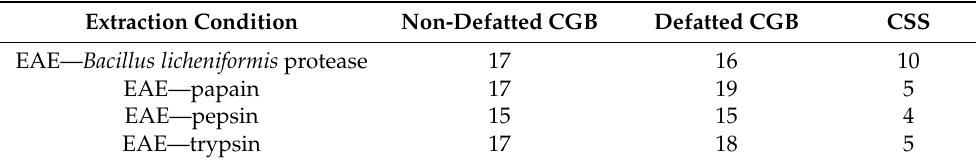
Table 2. The real protein content of the extracts obtained with UAE and EAE, expressed as % on the dry weight (g DW). Extraction Condition Non-Defatted CGB